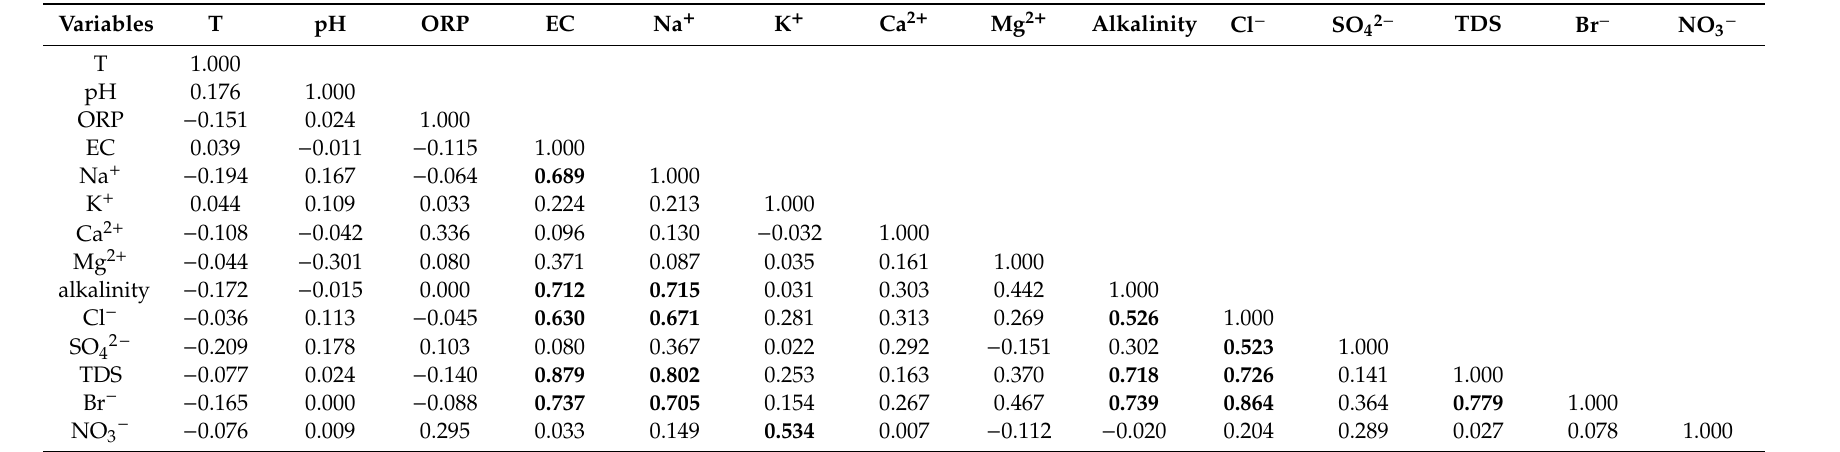
Table 3. Results of correlation matrix analysis using Pearson’s correlation coe ffi cient (R 2 ). Bold letter for R 2 >